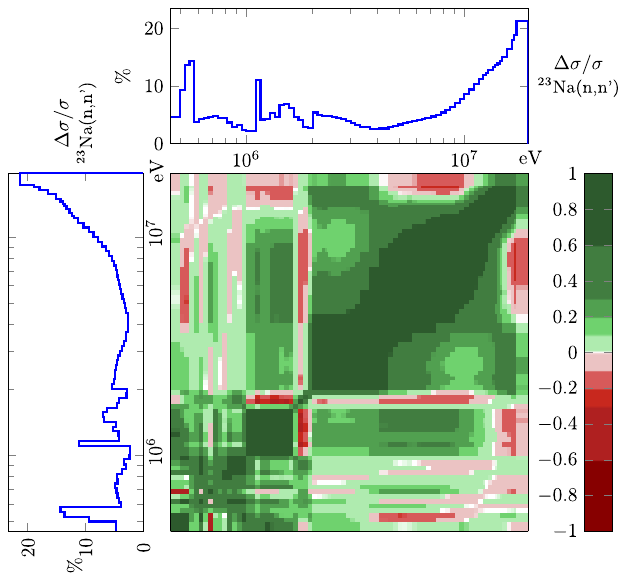
Fig. 8. New covariance evaluation with CONRAD of 23 Na ( n, n (cid:48) ) cross section [35] based on the analysis of JRC/Geel inelastic cross section measurements [36]. Figure taken from [11].